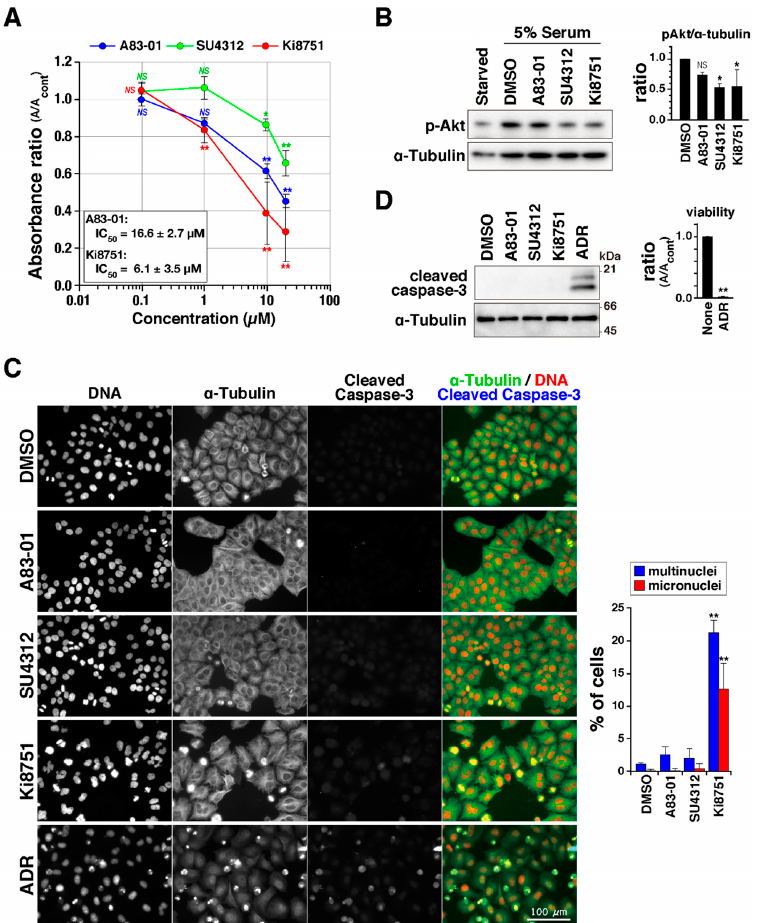
Figure 1. Vascular endothelial growth factor receptor (VEGFR) inhibitors suppress cell proliferation. ( A ) HeLa S3 cells were treated with A83-01, SU4312, and Ki8751 at the indicated concentrations for 2 days, and viable cells were determined by monitoring the absorbance of the formazan at 450 nm. Relative values are shown as a ratio of absorbance to solvent control (di-methyl sulfoxide, DMSO) using the mean ± S.D., calculated from three independent experiments. IC 50 was calculated in A83-01–, Ki8751–treated cells in each experiment, and the mean ± S.D. was shown in the graph. Asterisks indicate statistical significance (* p < 0.05; ** p < 0.01; NS, not significant), calculated using Scheffe’s F test. ( B ) Cells were cultured without serum for 1 day and then pretreated with the indicated inhibitors or DMSO as a solvent control for 30 min. Then, serum was added into the culture, and cells were continuously treated with inhibitors for 30 min. Whole cell lysates were analyzed using Western blot analysis with anti-phospho-Akt (pSer473) and anti- α -tubulin antibodies. Phosphorylation of Akt was quantified by measuring the signal intensity of the bands. The ratios of signal intensity of phosphorylated band of Akt to that of α -tubulin are shown as the mean ± S.D., calculated from three independent experiments. Asterisk indicates statistical significance (* p < 0.05; NS, not significant), calculated using Scheffe’s F test. ( C ) Cells were treated with 20 µ M A83-01, 20 µ M SU4312, 20 µ M Ki8751, and 4 µ M Adriamycin (ADR) for 24 h and then fixed and stained for DNA (red), α -tubulin (green), and cleaved caspase-3 (blue). Scale bar, 100 µ m. The number of cells with multinuclei or micronuclei was counted and is shown as the mean ± S.D., calculated from three independent